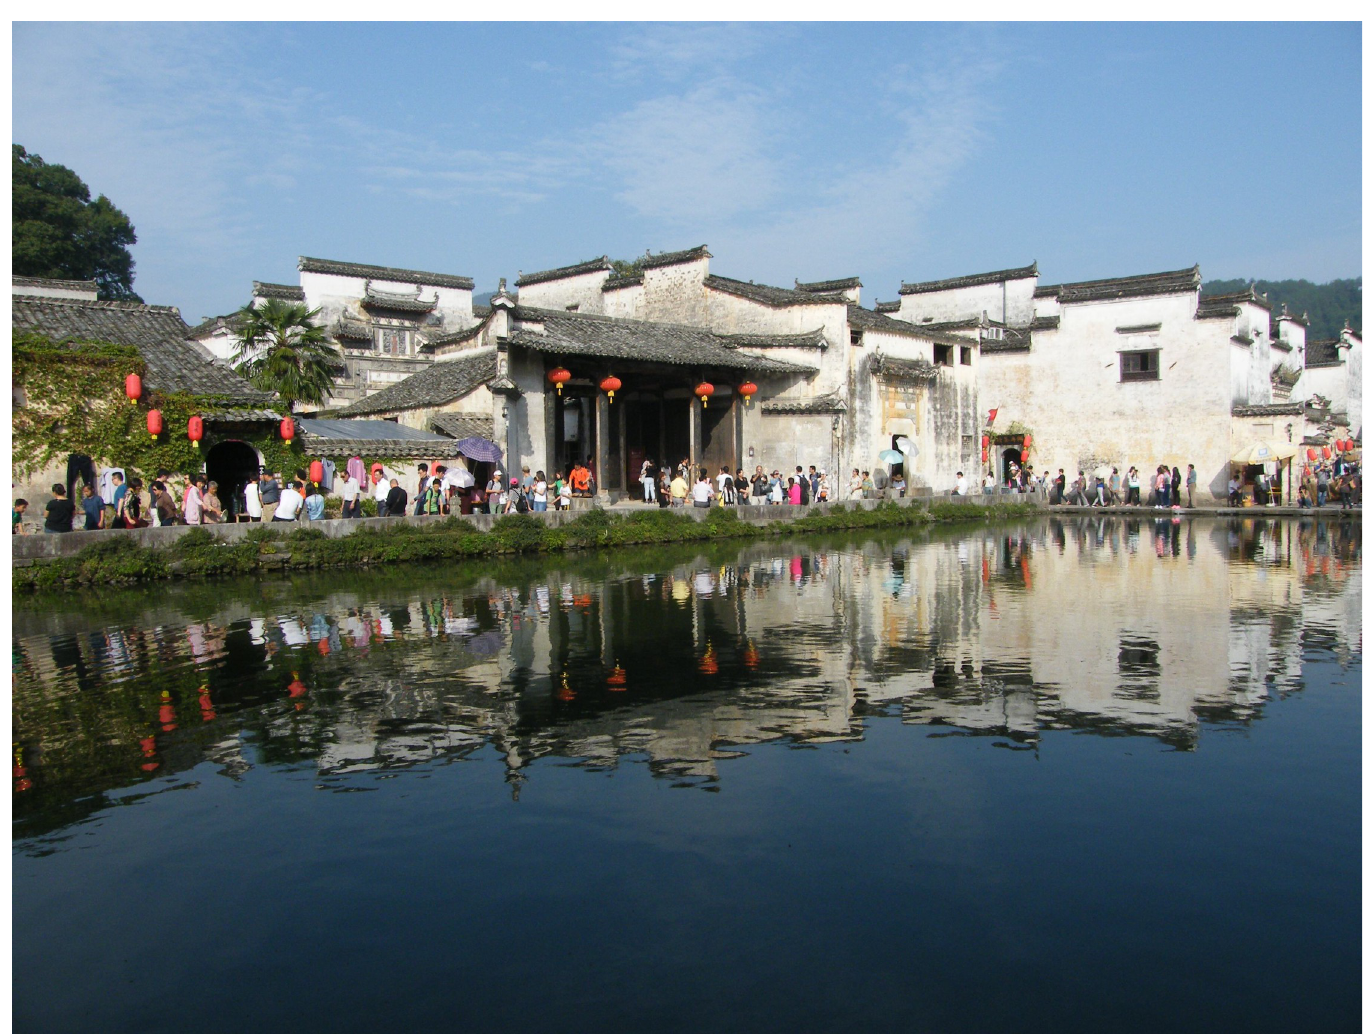
Fig 3. Moon Pond and the exterior of the traditional dwellings along the pond. Source: Taken by the